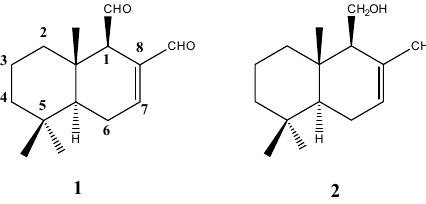
Figure 1. Chemical structures of polygodial ( 1 ) and drimenol ( 2 ).